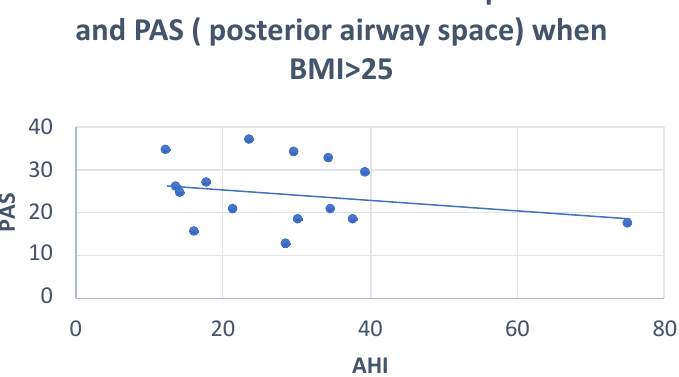
Figure 4. Scatter plot defining the correlation between AHI and PAS. r = − 0.24.